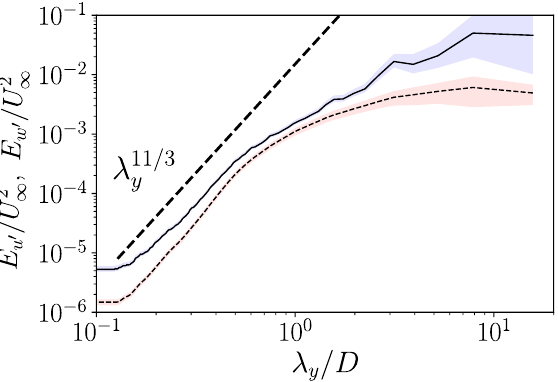
Figure 9. u (solid), w (dashed) energy spectra and their variability ( transparent blue and red). Energy spectra computed in spanwise wavenumber space, averaged temporally and in the streamwise, wall normal